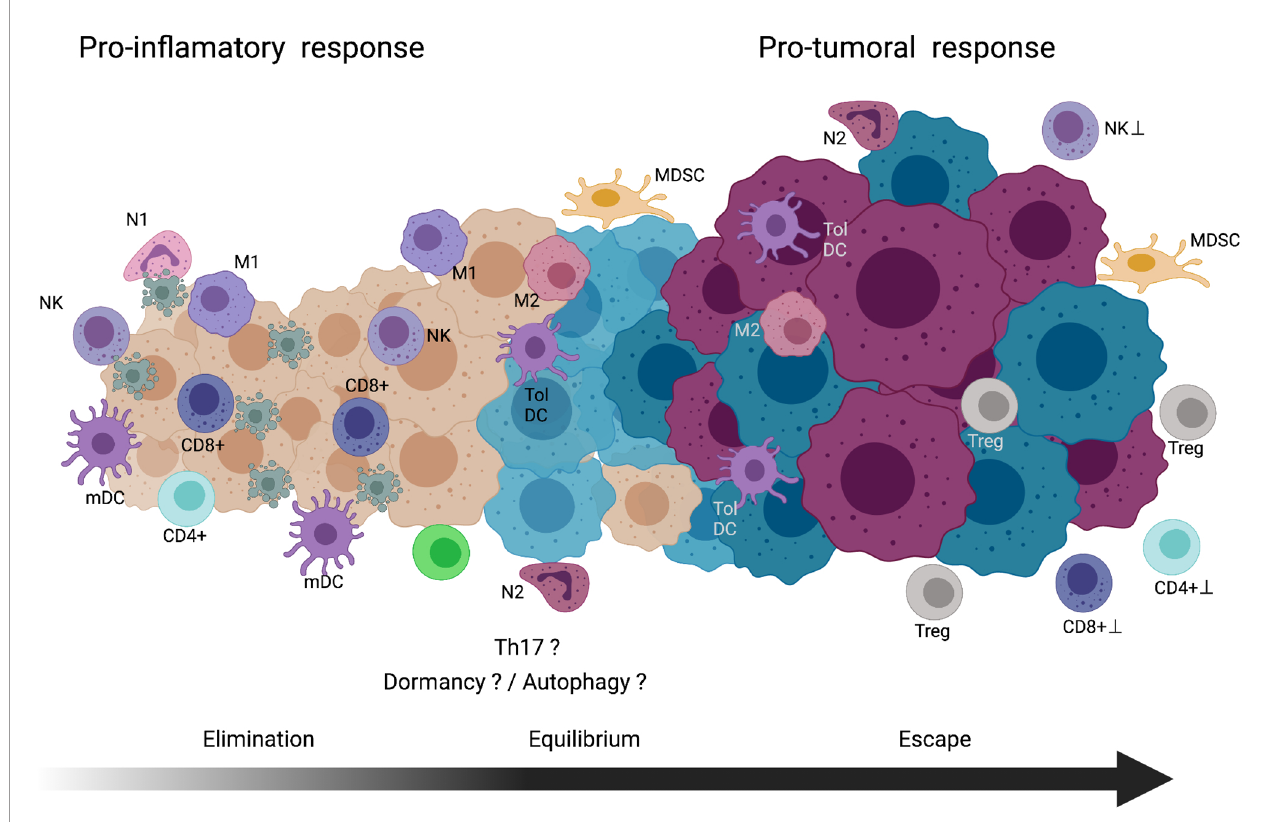
FIGURE 3 | Cancer immunoediting theory. Elimination phase , immune cells with pro-in fl ammatory activity involved in the recognition and cell death of nascent tumor cells are indicated. Equilibrium phase , tumor zones composed of immune cells with proin fl ammatory and protumoral activites coexist in the tumor. In this long phase, dormancy and/or autophagy of the tumor cells might be occurring. Also, in the chronic in fl ammatory environment the Th17 cells could be participating. Escape phase , in this fi nal step, tumor cells acquire mechanism to block the activity, cytocidal mechanisms of immune cells or maintain a microenvironment to promote in immune cells pro-tumoral activity. See text for further explanation. NK, natural killer cell; N1, type-1 neutrophil; mDC, mature dendritic cell; M1, type-1 macrophage; CD8+T, CD8 positive T-lymphocyte; CD4+T, CD4 positive T-lymphocyte; M2, type-2 macrophage; Tol DC, tolerogenic dendritic cell; N2, type-2 neutrophil; MDSC, myeloid-derived suppressor cell; Treg, regulatory T cell. Created with